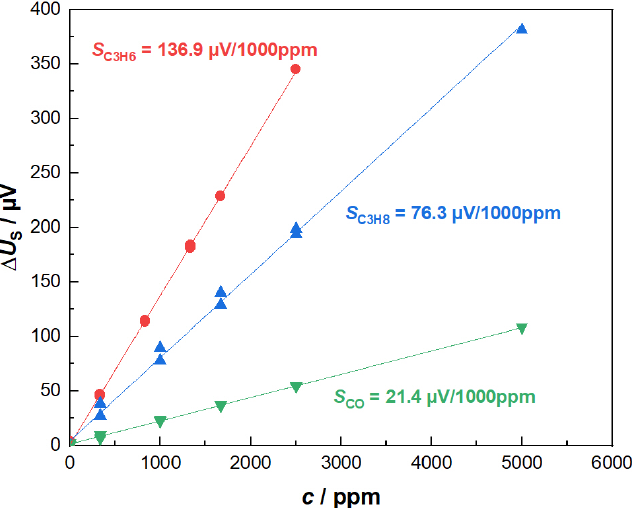
Figure 9. Characteristic sensitivity curves for Gen_2 sensors when they are exposed to model gases (base gas atmosphere: 10% O 2 and 2% H 2 O).